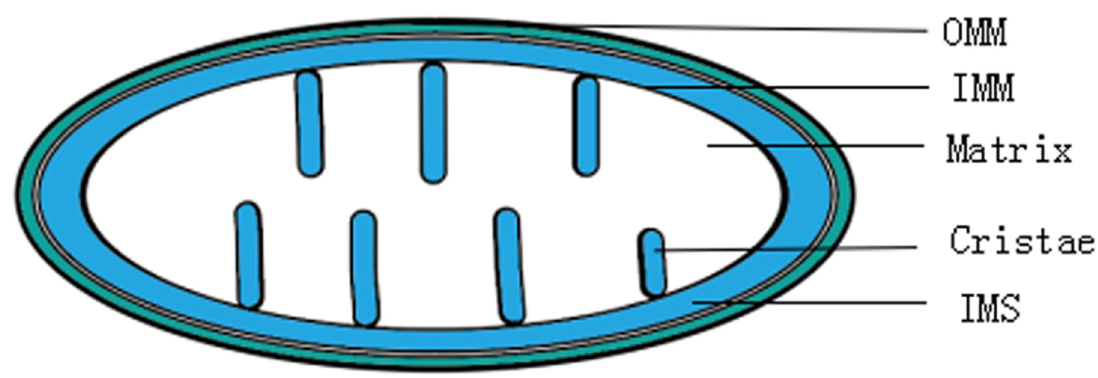
Figure 1. The structure of mitochondria. OMM: mitochondrial outer membrane. IMM: inner mitochondrial membrane. Cristae: mitochondrial inner membrane is depressed inward to form cristae. Matrix: internal space wrapped by the inner mitochondrial membrane. IMS: the space between the outer mitochondrial membrane and the inner mitochondrial